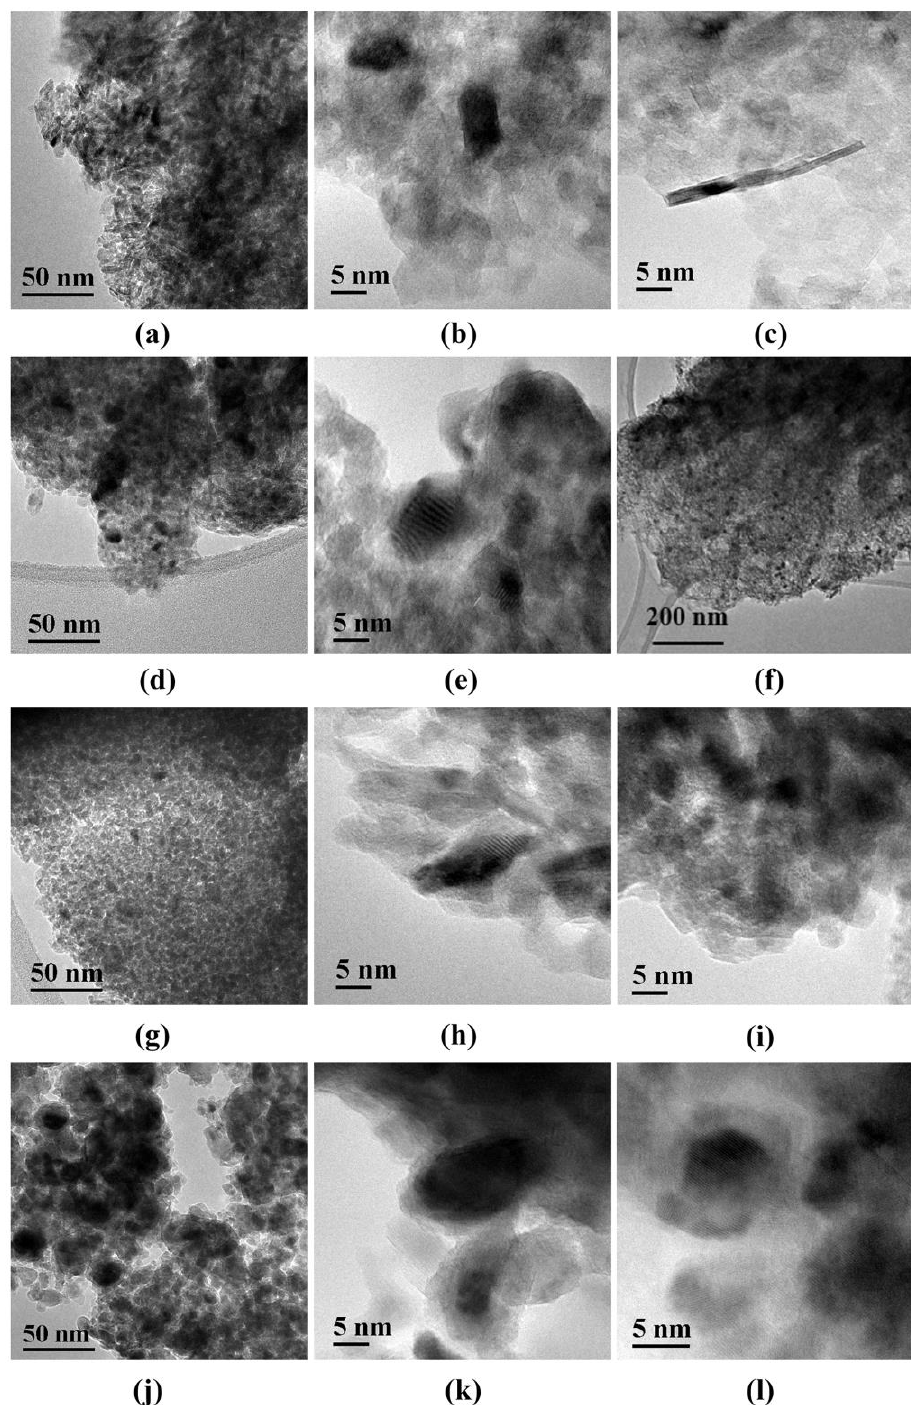
Figure 4. TEM images for the catalysts: ( a – c ) 0.5NiMgAl-2-R, ( d – f ) 0.5NiMgAl-4-R, ( g – i ) NiAl-3-R, ( j – l ) NiAl-4-R. Different areas of the catalysts showed a lattice fringe of 0.243 nm that was assigned to the planes of multiple Ni(Mg)Al-mixed oxides. The abundant ambiguous lattices indi- cate low crystallinity of the oxides, and this is in full compliance with XRD data. Addi- tionally, there were many areas with lattice fringes of 0.208 nm for NiAl-4-Red. This may